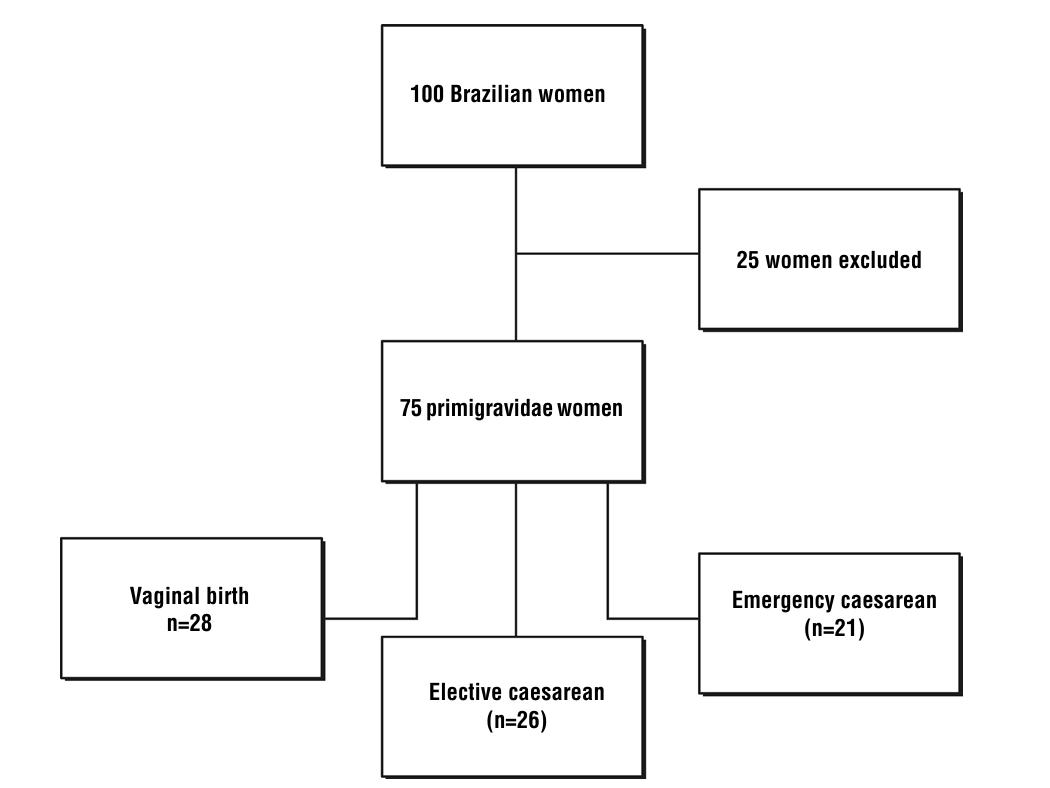
Figure 1 – Organogram representating the study